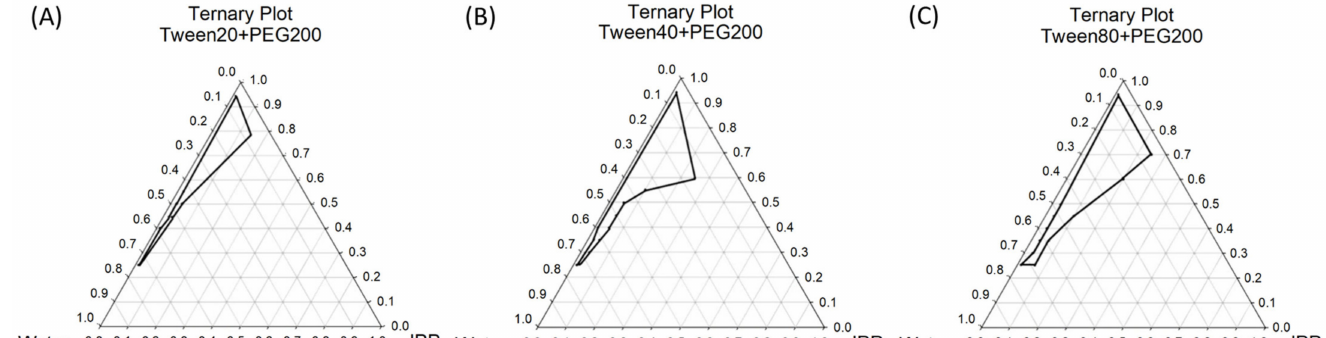
Figure 2. Pseudo-ternary phase diagram of the developed microemulsions: ( A ) ME-20-dA; ( B ) ME-40-dA; ( C ) ME-80-dA.